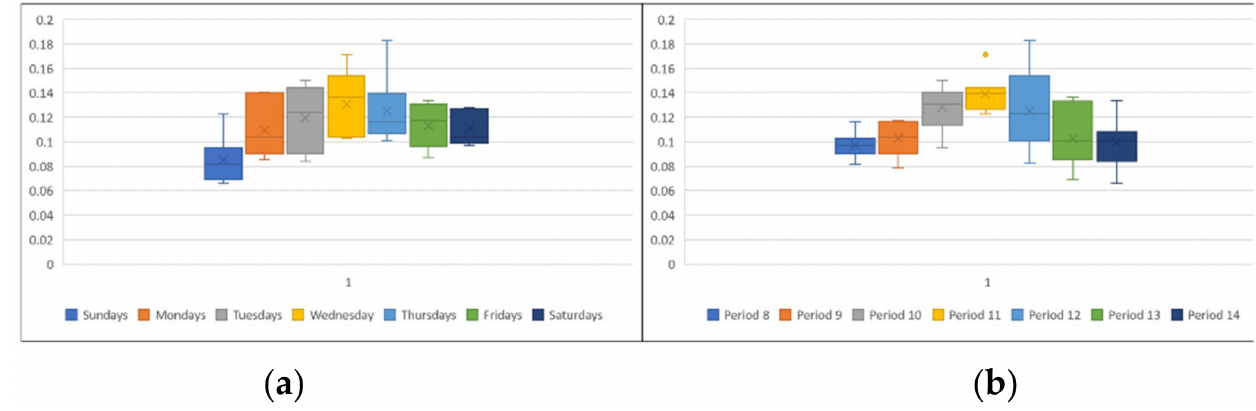
Figure 13. Carbon monoxide minimum, maximum and average over ( a ) all weekdays and ( b ) peri- ods in Santiago de Los Caballeros from period 8 to 14.